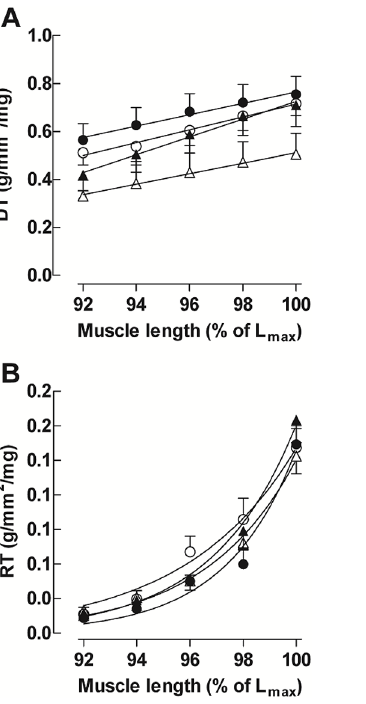
Figure 3. Frank-Starling relationship. Values are expressed as the mean 6 SEM of left ventricular papillary muscle developed (A) and N resting (B) length-tension curves obtained from untrained ( # ), trained ), untrained + steroid ( n ) and trained plus steroid ( m ) rats. A : straight ( lines were fitted to the developed length-tension relationships using linear regression analysis. B : the resting tension-length curves for the four groups were fitted to mono-exponential non-linear relationships.